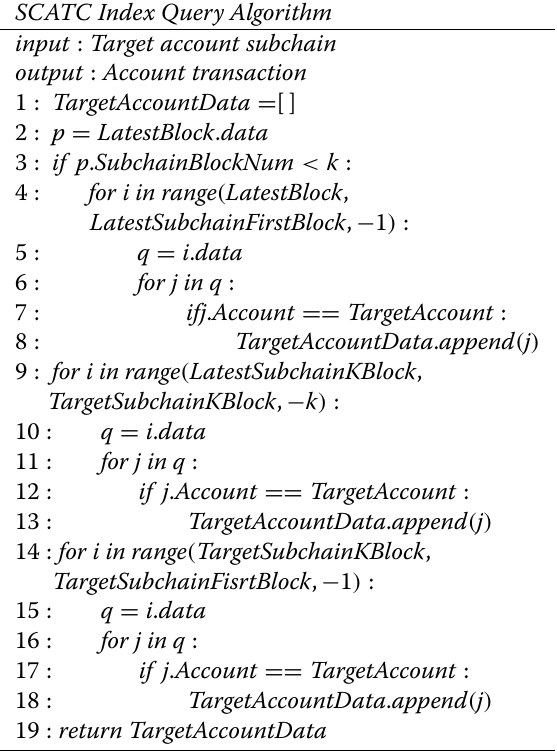
SCATC Index Construction